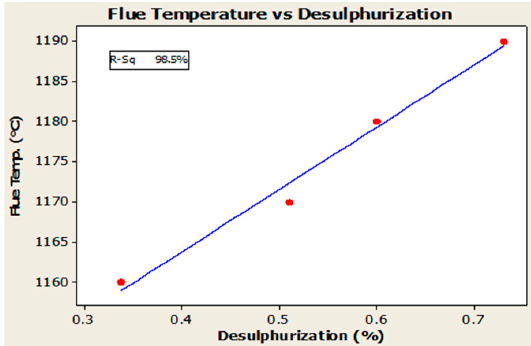
Figure 12. Flue temp. vs. desulfurization.